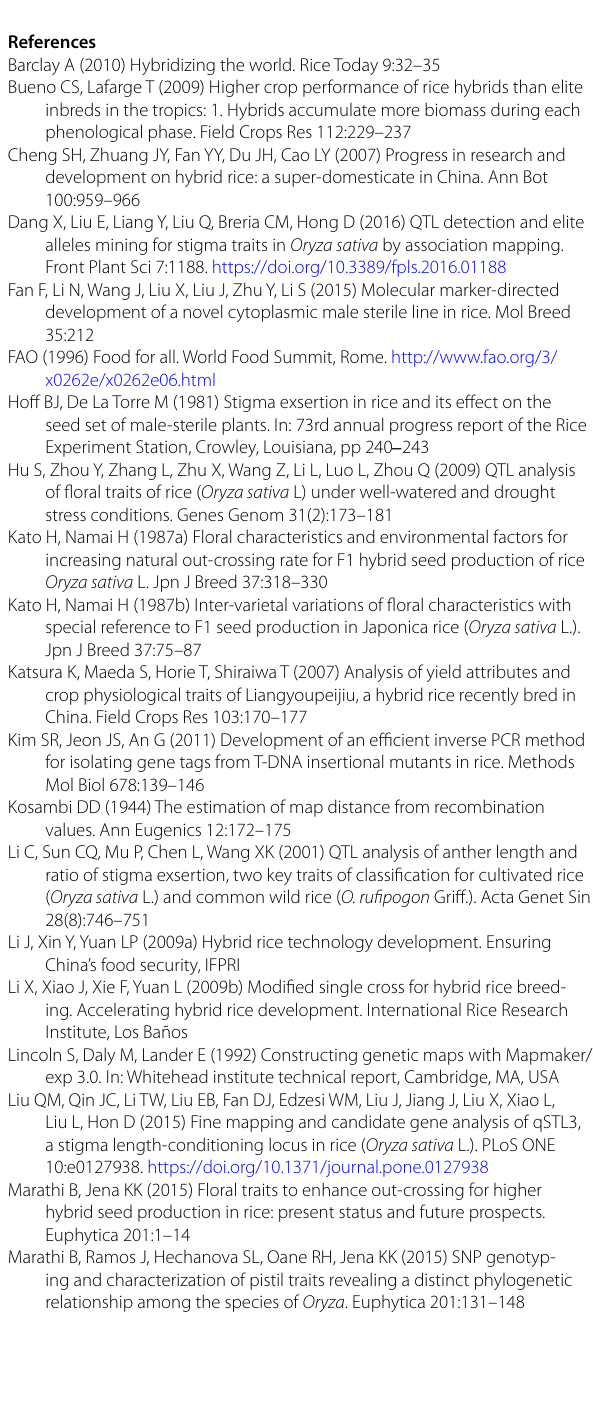
Additional file 4 : Figure S1. Schematic diagram showing the different parts of the typical OL female reproductive organ (pistil). The letters a, b, c, d, e, and f denote non‑brushy parts of the stigma, brushy parts of the stigma, stigma, style, ovary, and pistil, respectively. Additional file 5 : Figure S2. Breeding scheme depicting the development of a mapping population derived from